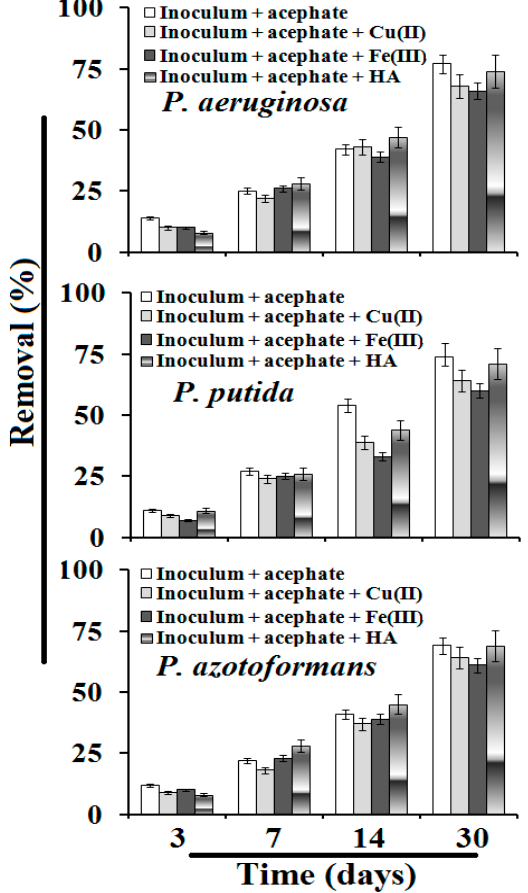
Figure 2. Removal (%) of acephate after incubation with three strains in M9 medium under different conditions.